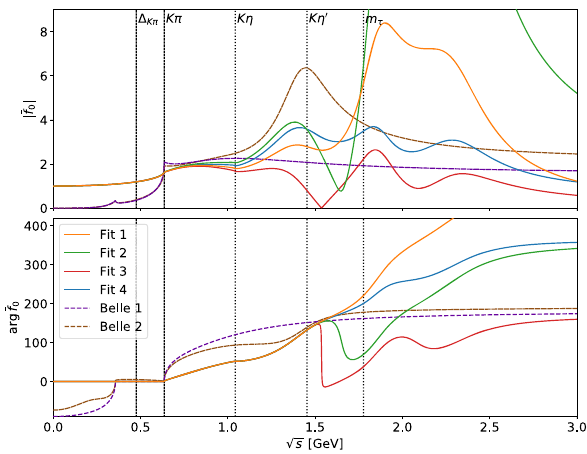
Fig. 6 Scalar form factor ¯ f 0 (top: modulus, bottom: phase) with the parameters of the fit results of Table 3